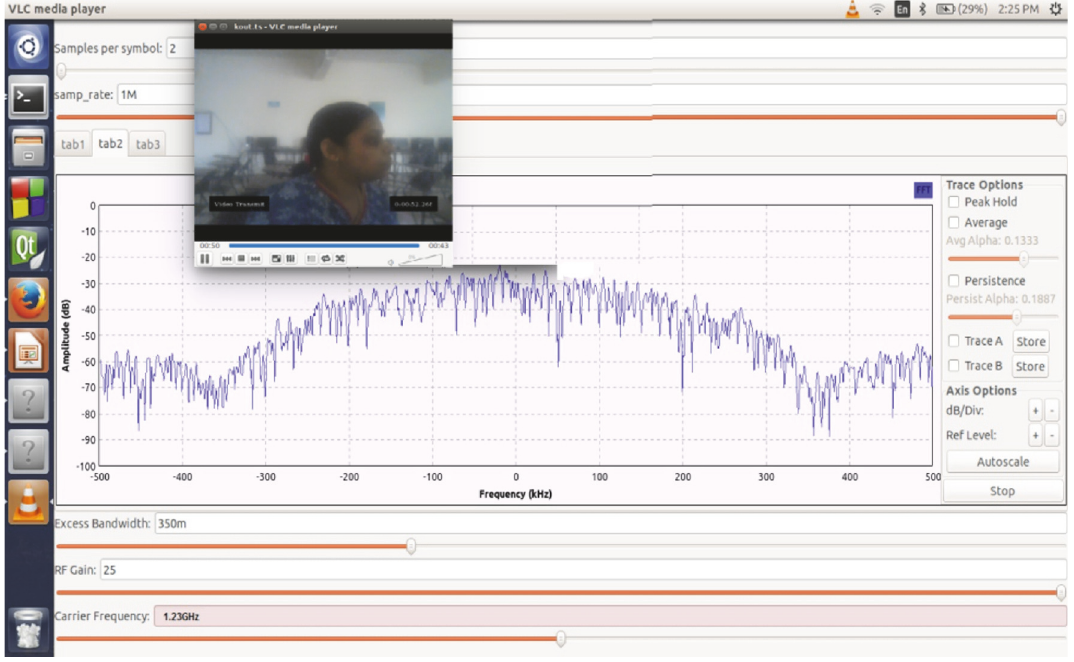
Figure 10: Spectrum of received signal (FFT